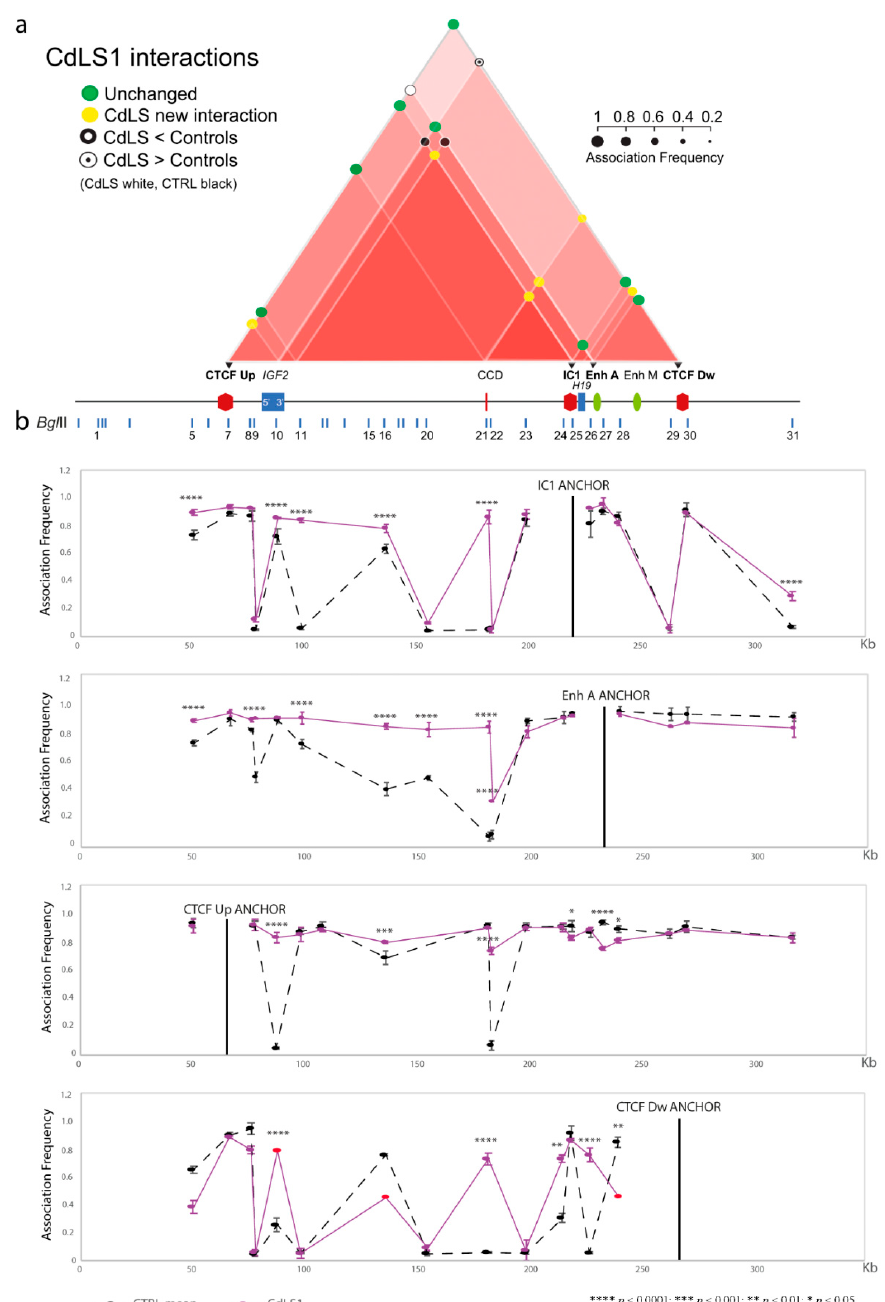
Figure 2. Abnormalities in chromatin architecture at the IC1 locus of the CdLS1 cell line ( SMC1A mutation). The figure is to scale. ( a ) Scheme of the statistically significant modifications in the chromatin interactome of the IC1 domain in the CdLS1 cell line compared with the mean of the controls. Interactions between different elements of the IC1 region are shown by red triangles; increasing color intensity corresponds to an increase in the number of interactions of the sub-region. Colored circles represent association frequencies as described in the figure. Black triangles indicate the anchors used for 3C analysis. A linear representation of the IC1 imprinted domain is depicted below the interactome. ( b ) IC1 locus looping profiles for the indicated anchors in controls (dotted black) and CdLS1 (pink) cell lines. BglII restriction sites are indicated above. Each point in the profile is the mean ± standard deviation of two independent 3C experiments and indicates the association frequency between the anchor and the fragment on the left of the corresponding BglII restriction site. Differences (two-way ANOVA test) are indicated by asterisks. Red dots indicate the points with standard deviation